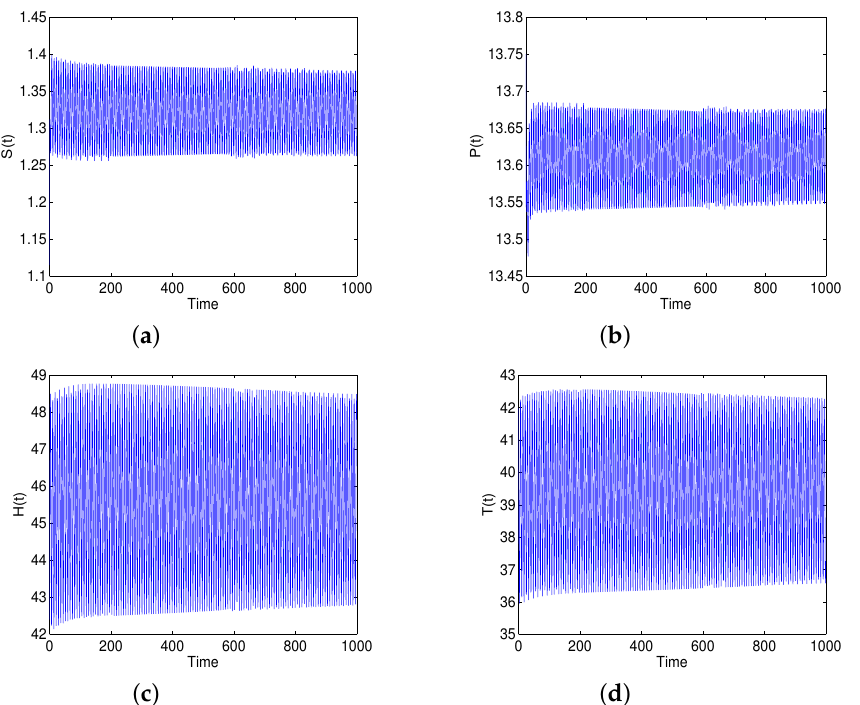
Figure 6. The time plot of ( a ) susceptible population, ( b ) psychological addicts, ( c ) physiological addicts and ( d ) drug-users in treatment for τ 1 = 1.4308 > τ 1 ∗ = 1.4096 and τ 2 = 2.5 ∈ ( 0, τ 20 ) with A = 2, d = 0.02, β 1 = 0.016, β 2 = 0.028, π = 0.03, γ = 0.095, θ = 0.5 and σ = 0.21.